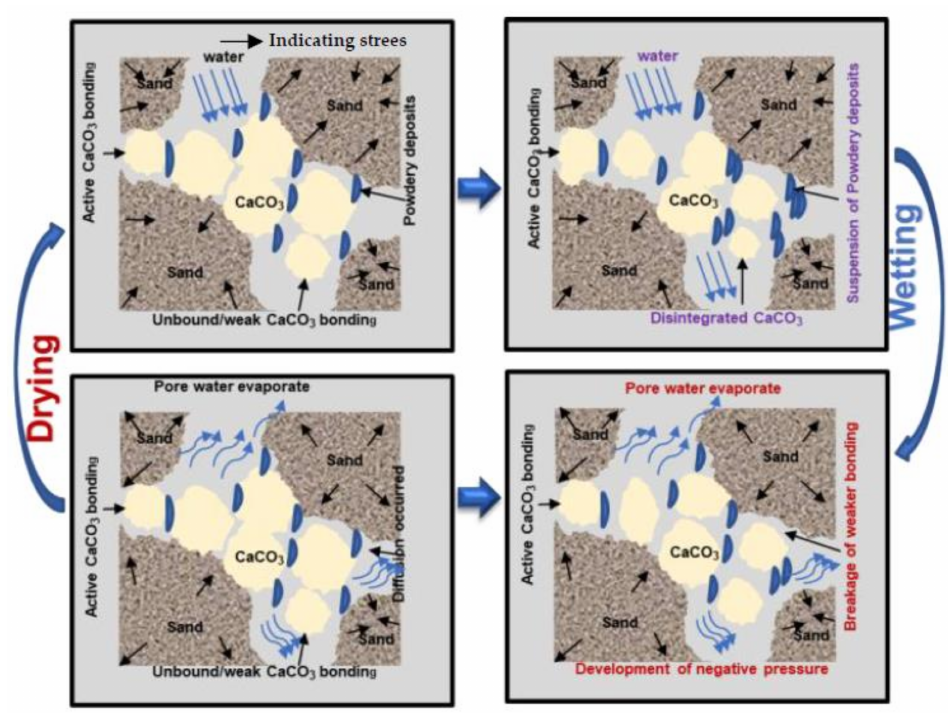
Figure 10. Schematic illustration of the deformation process of MICP-treated specimens after exposure to WD cycles (without the addition of fiber).